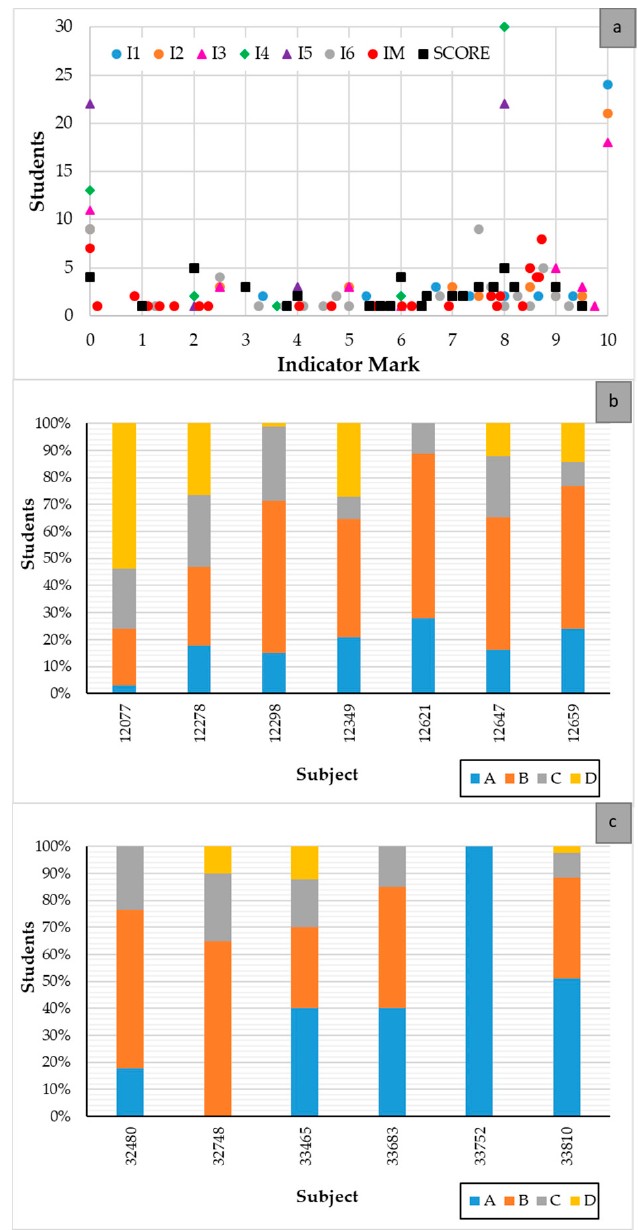
Figure 3. ( a ) Indicator in hydraulic machines related to Table 2; ( b ) results of the descriptors